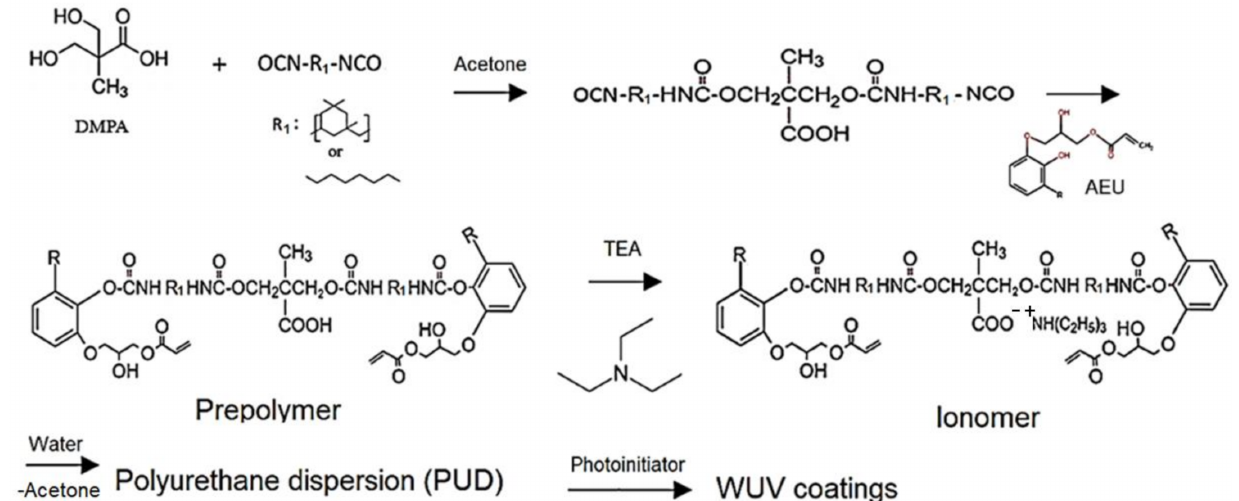
Figure 2. Manufacture of the urushiol-based WUV